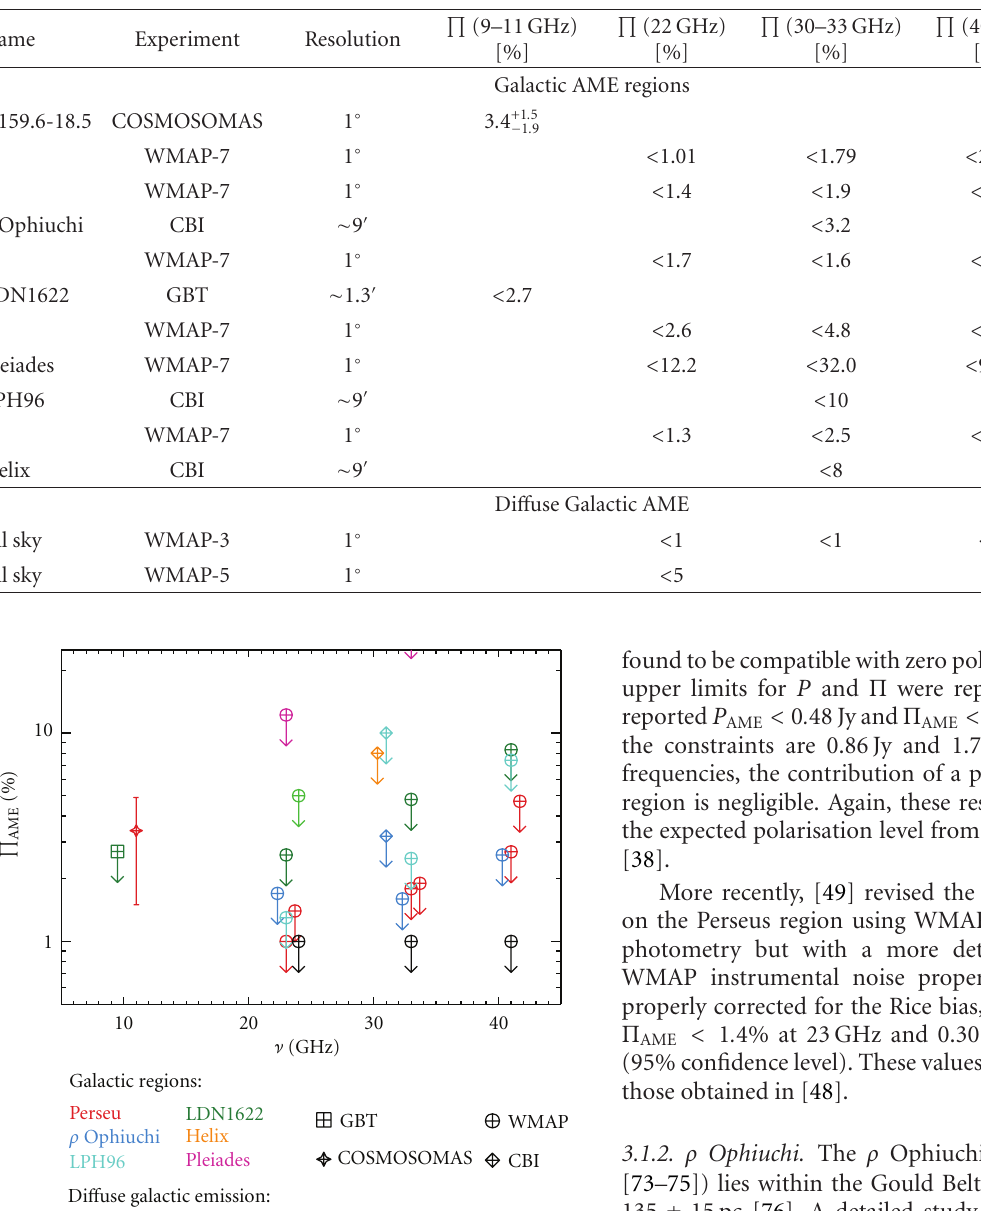
Table 1: Summary of the current constraints on the fractional polarisation ( Π ) of the AME both for individual Galactic objects and for large-scale (di ff use) measurements. Columns 1 to 3 indicate the region, the experiment used for this particular constraint, and the angular resolution, respectively. The following four columns indicate the constraints on the fractional polarisation ( Π ), separated according to the frequency band for an easier comparison. When quoting upper limits, the 95% confidence level is used. Last column provides the relevant references.